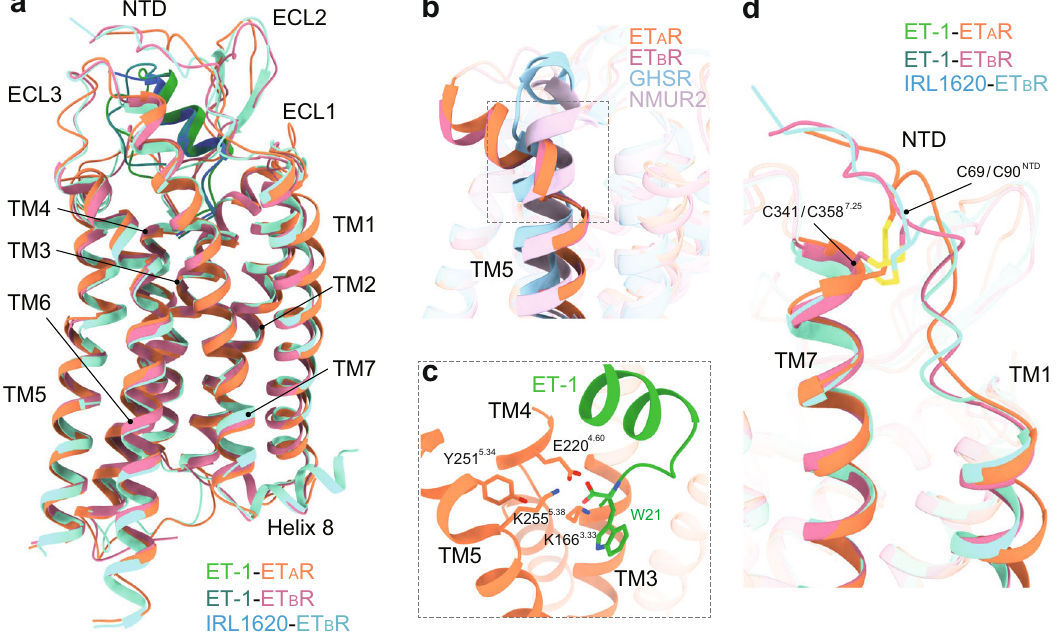
Fig.2|Structurefeaturesofendothelinreceptorsintheactivestate.a Structure superpositionofET1-boundandIRL1620-boundETRs. b Structuresuperpositionof ET-1-bound ETRs and other active class A peptide GPCRs, GHSR (PDB: 7F9Y), and NMUR2 (PDB: 7W55). The notable outward kink of the extracellular part of TM5